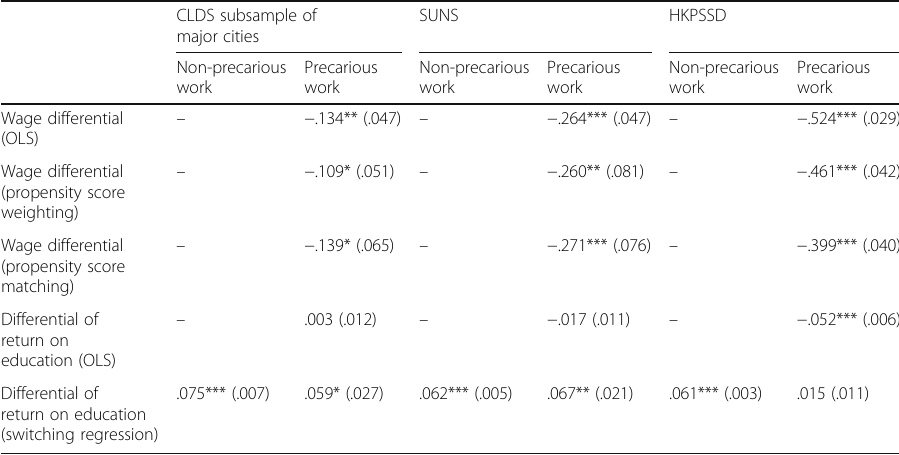
Table 6 Differentials in wages and return on education between precarious workers and non- precarious workers in mainland China and Hong Kong (robustness